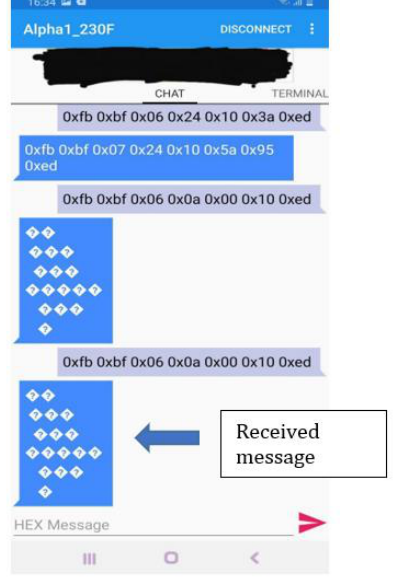
Figure 17. Response of the robot.